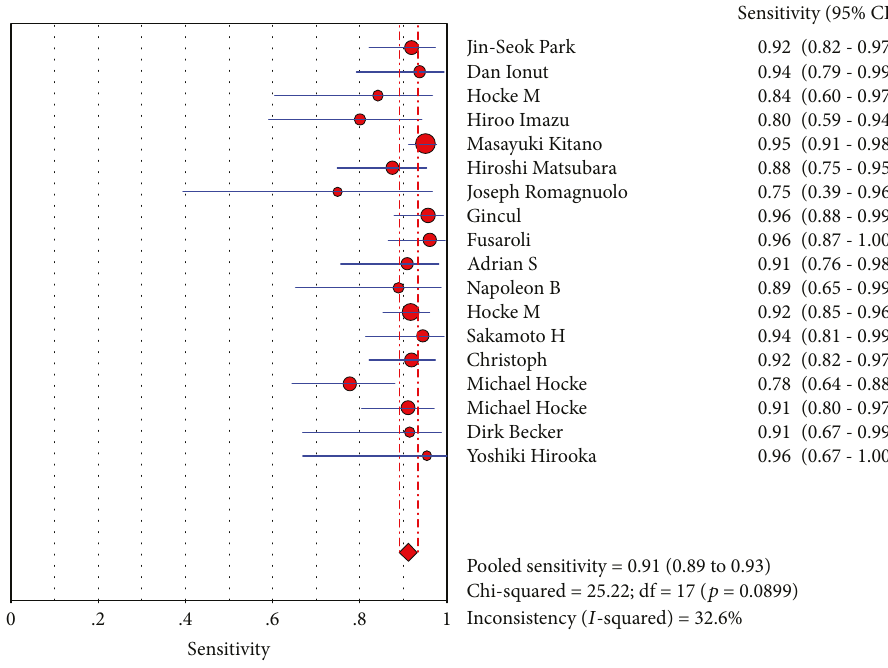
Figure 2: Sensitivity of the selected studies and this